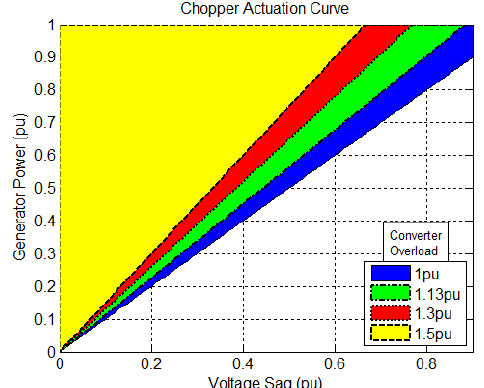
Figure 9. Chopper actuation limits during balanced voltage sags according to the converter current limits.